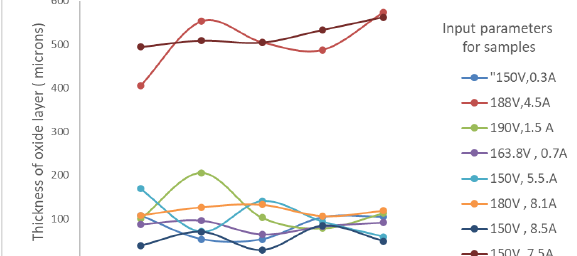
Table 2: Experimentation parameters.